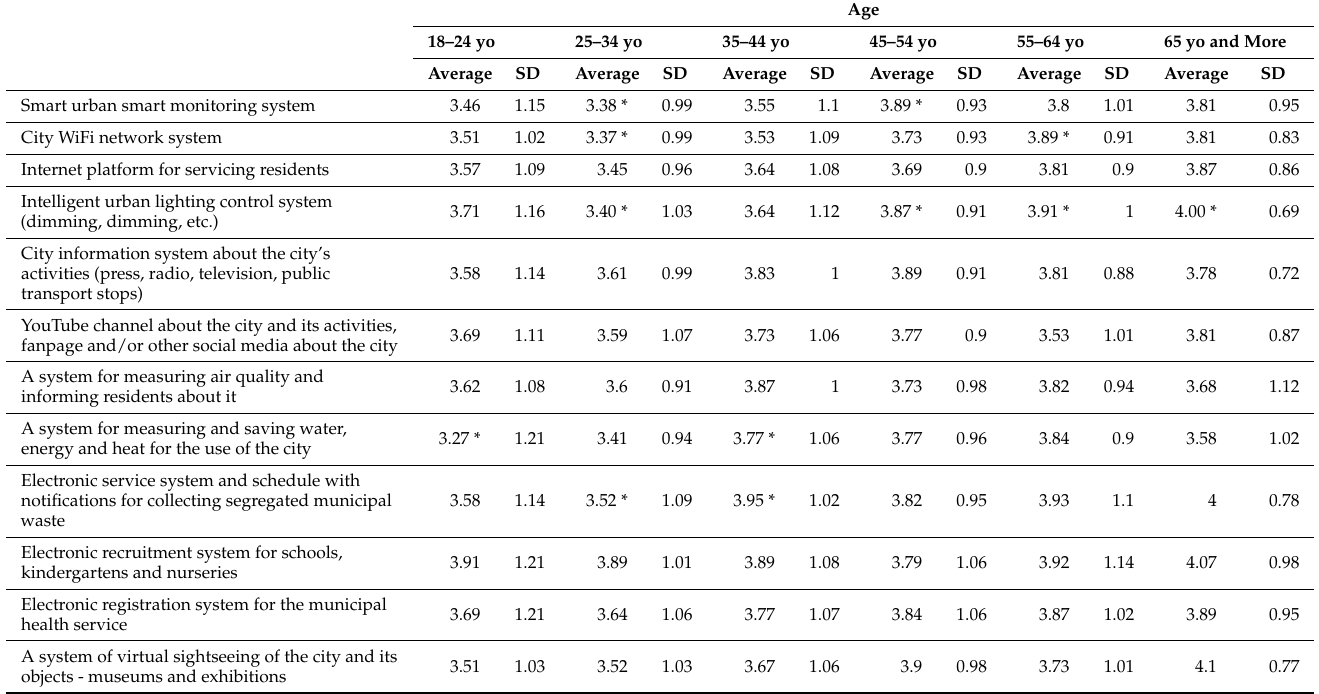
Table 3. Evaluation of the level of improvement of city services as a result of the implementation of smart technologies depending on the age of the